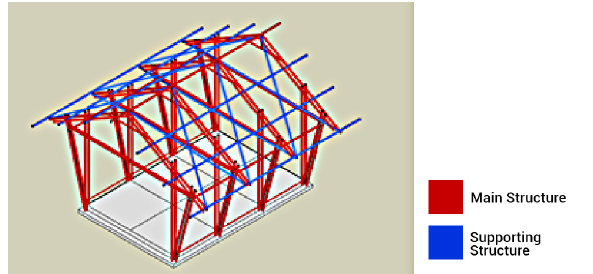
Fig. 5. Main and Supporting Structural Systems Are